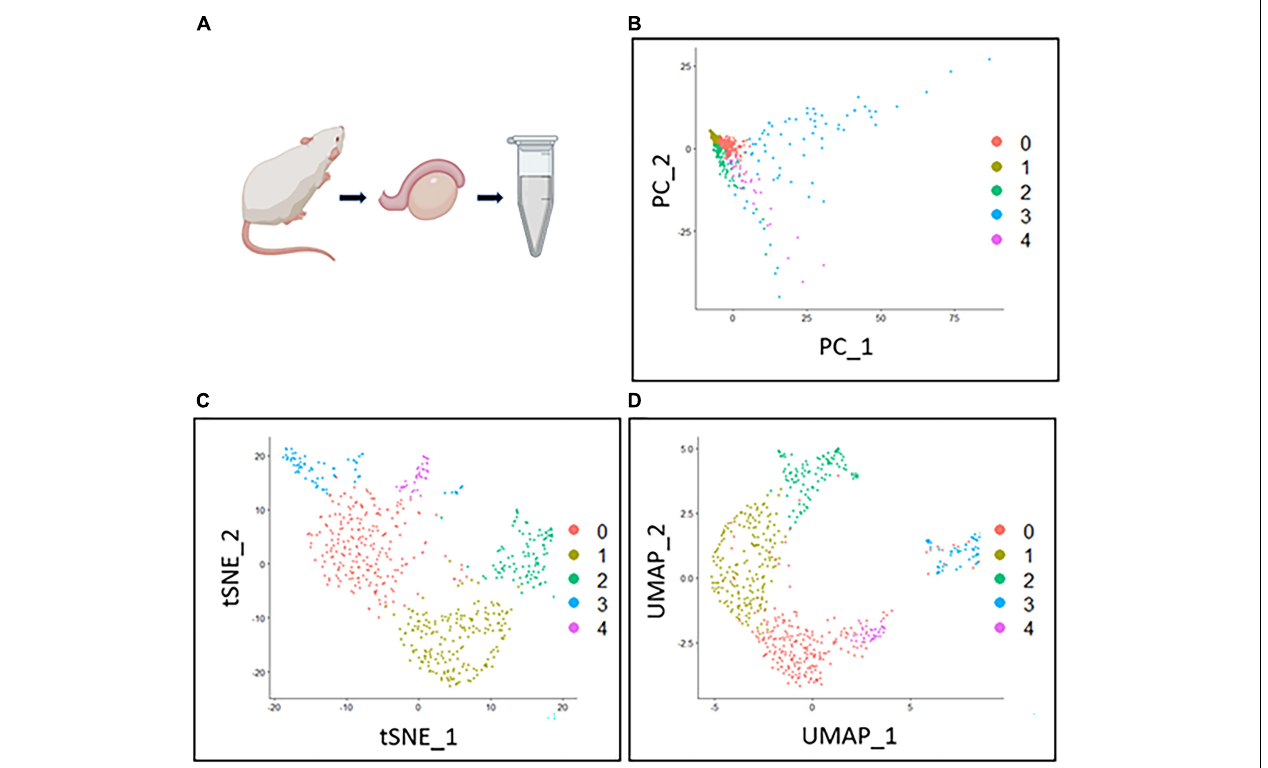
FIGURE 2 | Comparison between three dimension-reduction methods of scRNA-seq data analysis. The Drop-seq testis cell data was progressed by quality control and normalization. The polished data then underwent three different dimension-reduction methods for cell clustering. Each dot in (B–D) represents a cell. (A) The mouse testis data is from a previous publication (Jung et al., 2019). (B) The filtered testis data were processed by PCA and plotted by the first two principal components. Cell clusters were generated and shown in different colors. (C) The same dataset is processed by TSNE for clustering and plotted by the first two dimensions. Cluster separation of TSNE is better compared to other methods. (D) The same dataset is processed by UMAP for clustering and plotted by the first two dimensions. The distance between different clusters reflects the farther or closer relationships between the cell